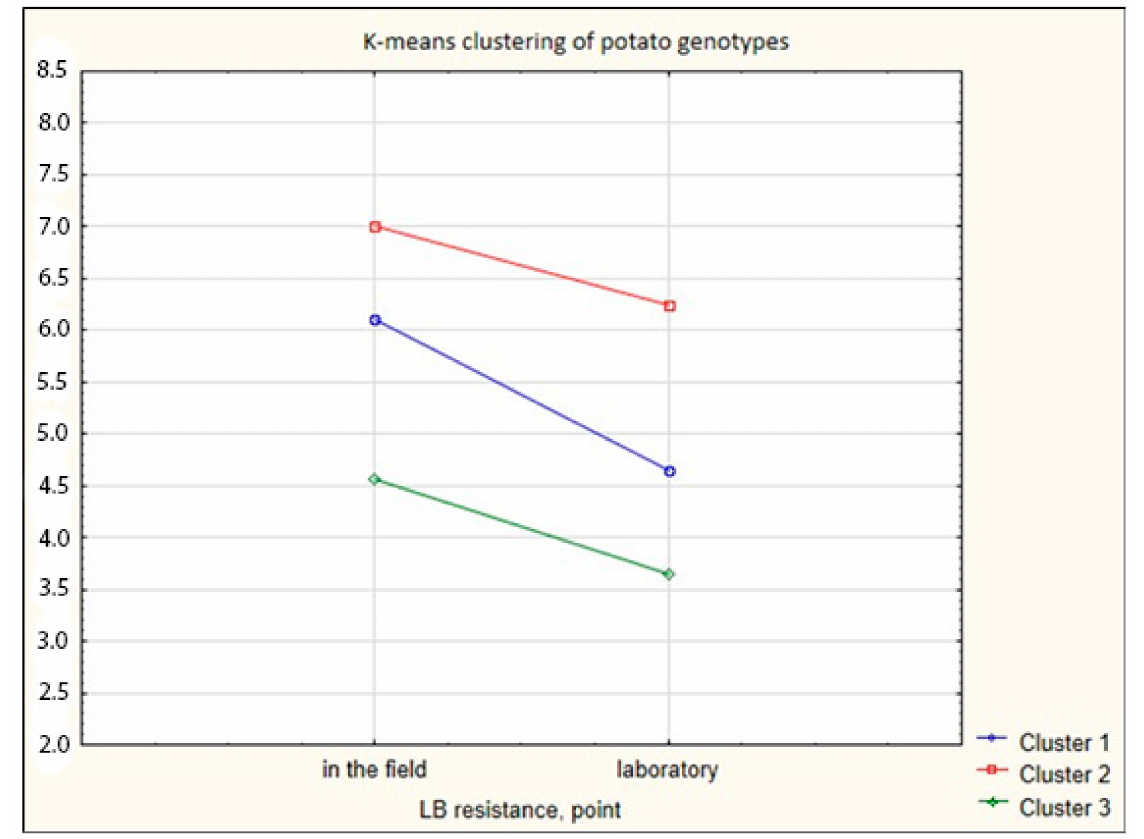
Figure 3. K-means clustering of potato